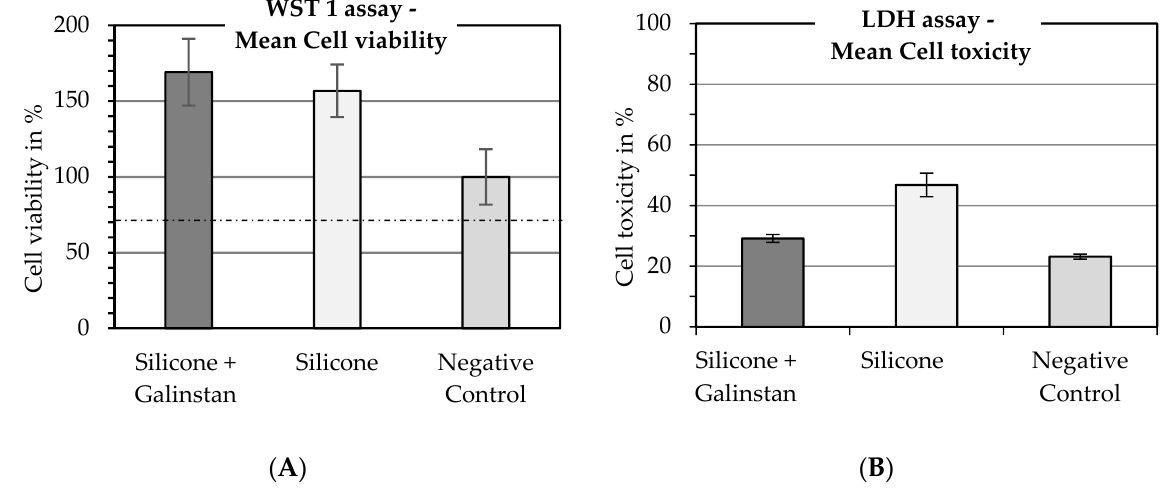
Figure 5. Results of biocompatibility tests using conditioned media. ( A ) Cell viability of galinstan–silicone rubber and silicone rubber measured with the WST-1 assay; N = 18; dotted line is at 70%; ( B ) cell toxicity of galinstan–silicone rubber and silicone rubber measured with LDH assay; N = 6.